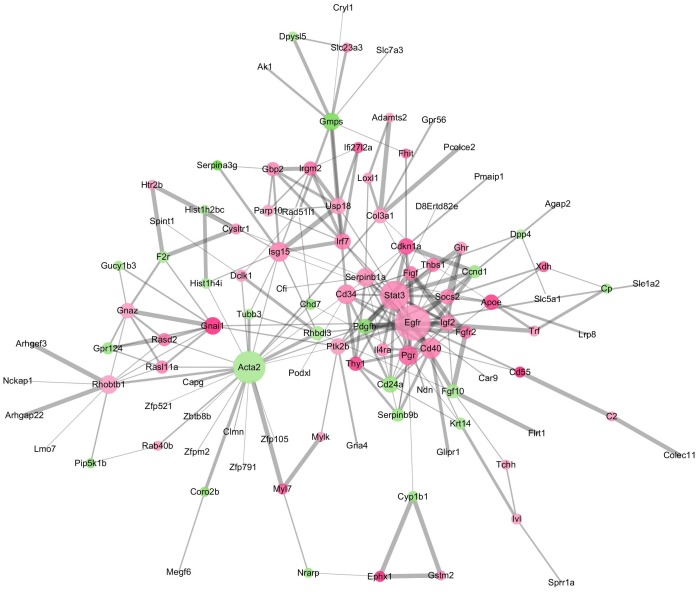
The DEGs-formed protein-protein interaction network.The red and green circles represent up- and down-regulated genes, respectively. The node represents genes and edges for their role in connection between proteins. The nodes are colored based on in-between significance, and the higher the value, the darker the color, whereas the node size is proportional to the degree value, i.e., the higher the value, the bigger the size. The thicker the line, the tighter the connection between the two proteins.